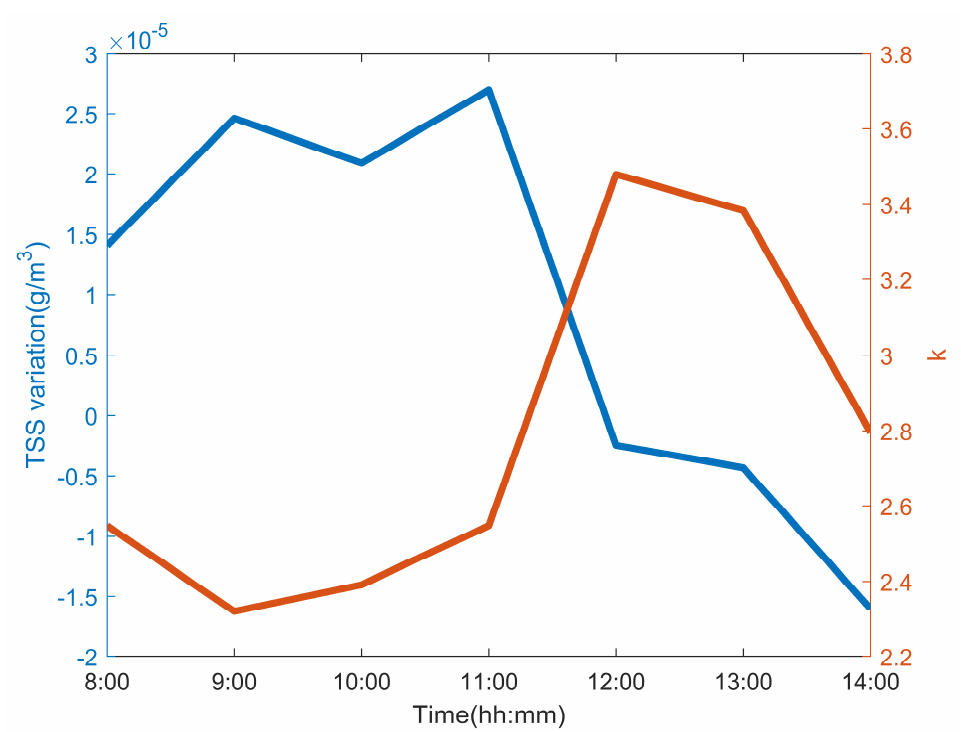
Figure 11. The evolution of Simpson − Hunter index k versus hourly variations in TSS from 8:00 to 14:00.